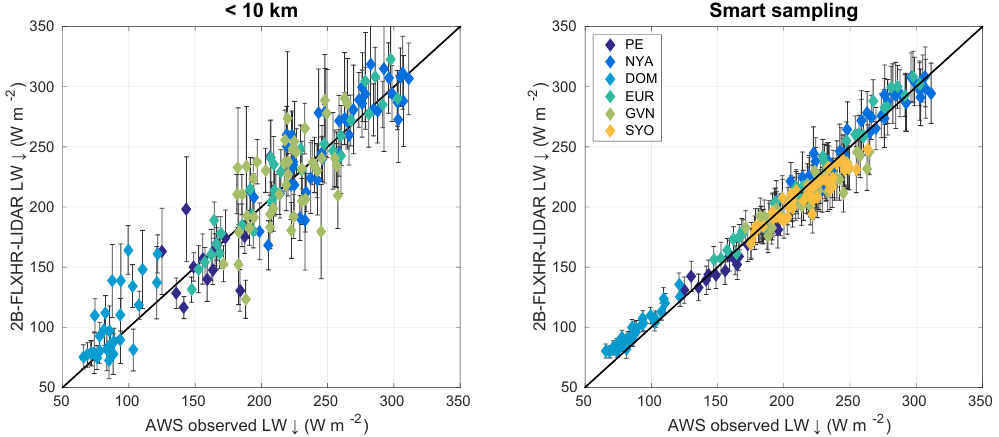
Figure 9. Monthly mean LW ↓ radiation comparison between 2B-FLXHR-LIDAR and AWS (2007–2010). Based on retrievals comprising of all satellite samples <10km from station ( r = 0 . 94) (left). Based on all satellite samples resulting from the smart sampling approach ( r = 0 . 99) (right). Table 3. Maximum distance (km) used for sampling as determined by the smart sampling approach for the different AWS locations. POI PE NYA DOM EUR GVN SYO Max. dist. (km) 309 224 258 138 417